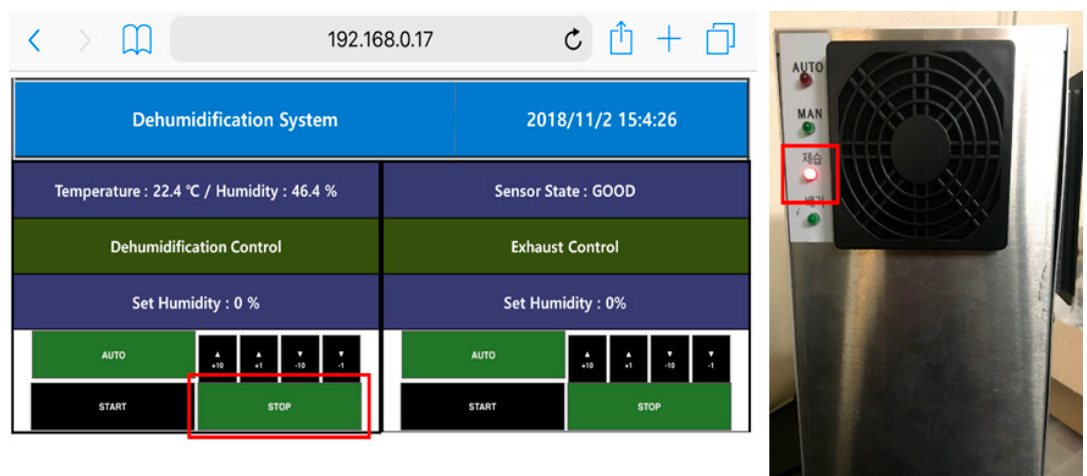
Figure 9. Dehumidification control—“START” mode.